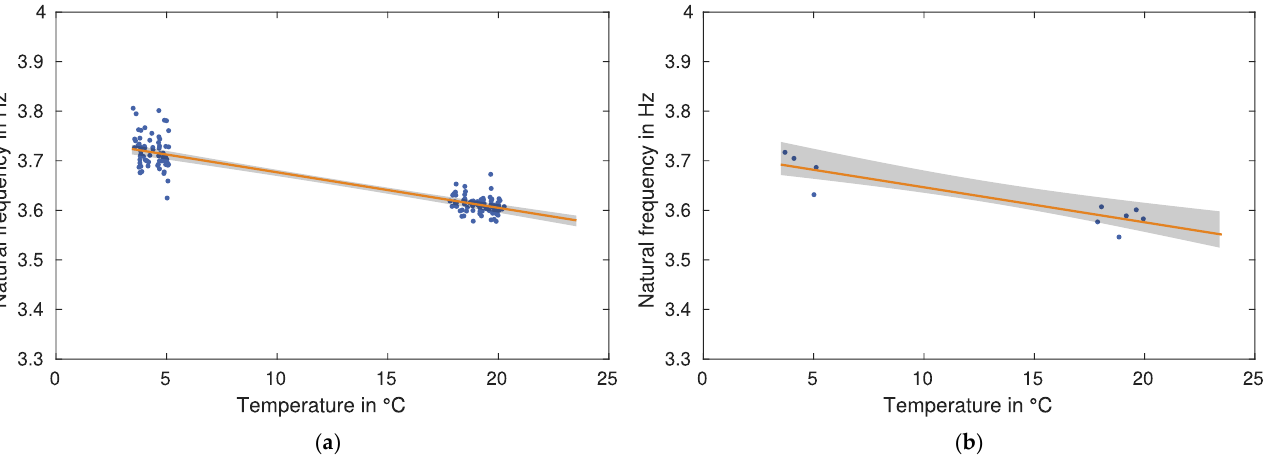
Figure 8. Variation of the linear regression with GBR data for a sample size of 25% and a reduction of the measurement days to the 23 and 24 October 2019: ( a ) Least squares with best approach . ( b ) FDD with a time window of 10min.